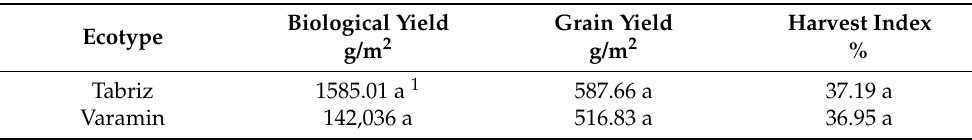
Table 2. Mean comparison of grain production traits of two dill ecotypes under chemical and biofertilizer